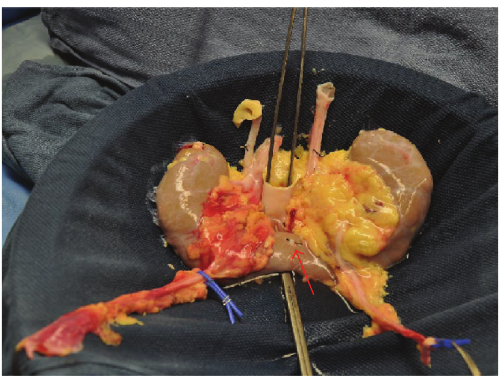
Figure 1: Horseshoe kidney. The red arrow points to the accessory artery feeding the bridge of the horseshoe kidney. The indicated artery was ligated during back-table preparation of the kidneys.